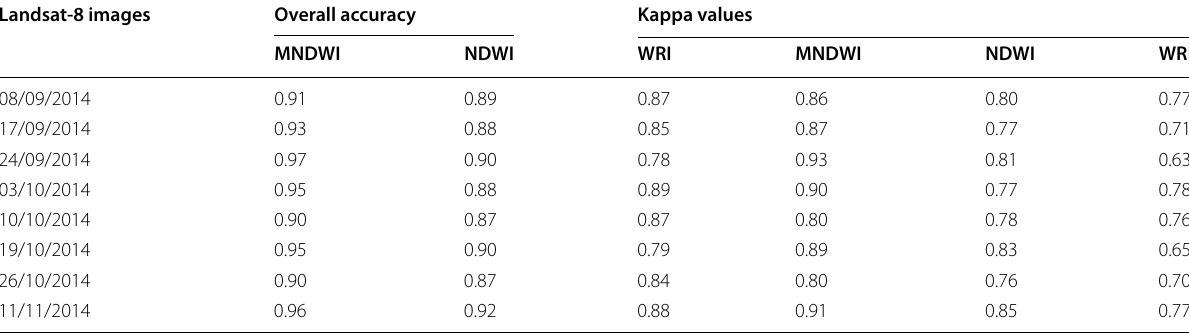
Table 2 Overall accuracy assessment and Kappa coefficient values of RFM produced by used water indices Landsat-8 images